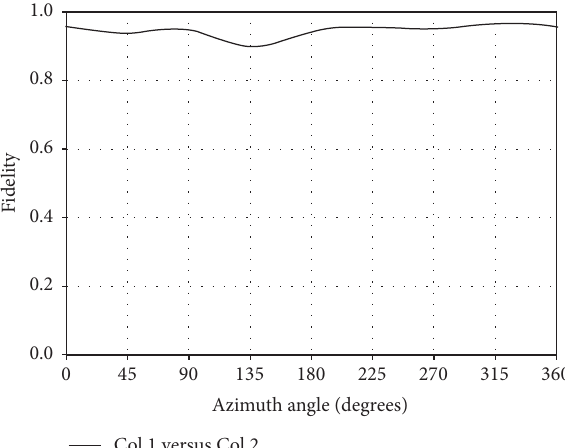
Figure 9: Measured fidelity factor of the proposed antenna in azimuth plane.